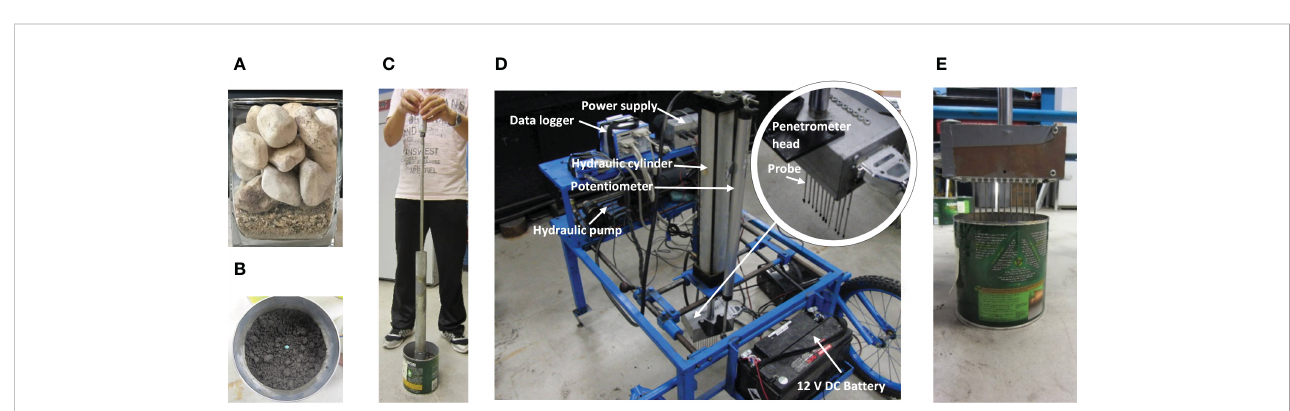
FIGURE 2 Experiments. (A) Emergence test with gravel as the growth medium. (B) Emergence test with soil as the growth medium, showing the soybean seed planted. (C) Soil being compacted by a proctor. (D) Micro-penetrometer. (E) Probes penetrating the soil for measurements of soil cone